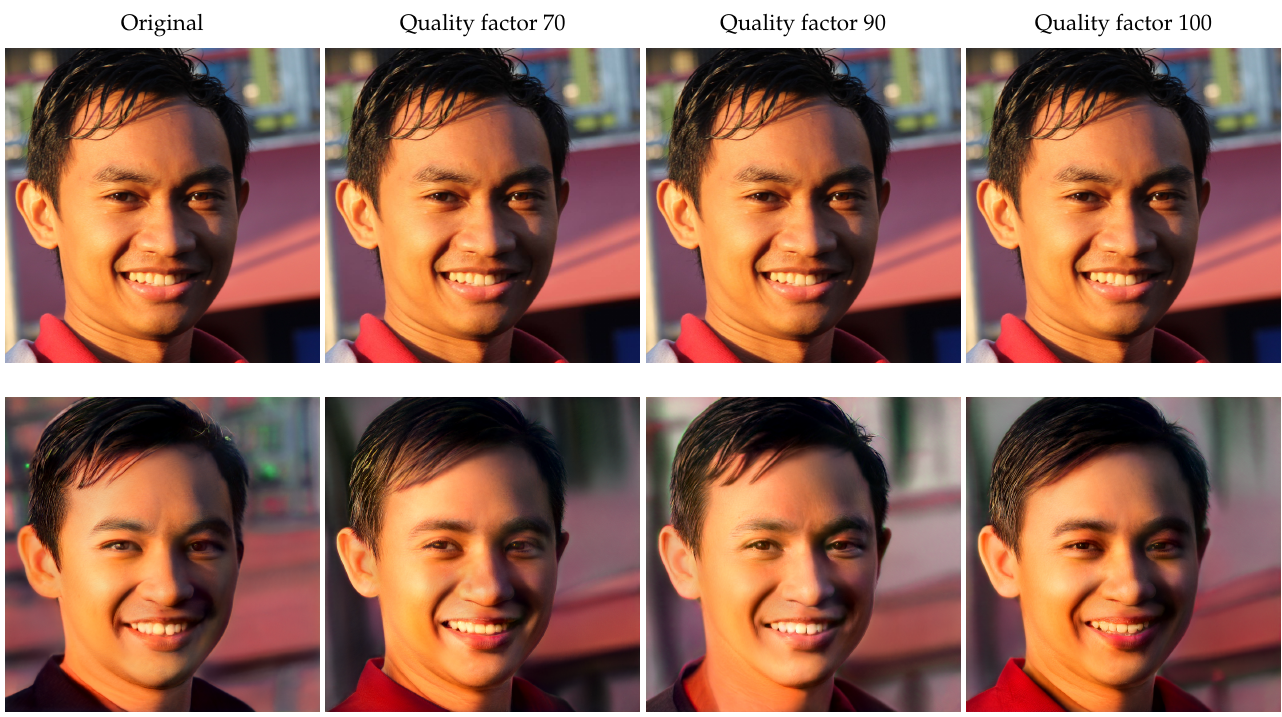
Figure 15. Examples of face images before (top row) and after (bottom row) the reconstruction when different JPEG quality factors are applied as post-processing.